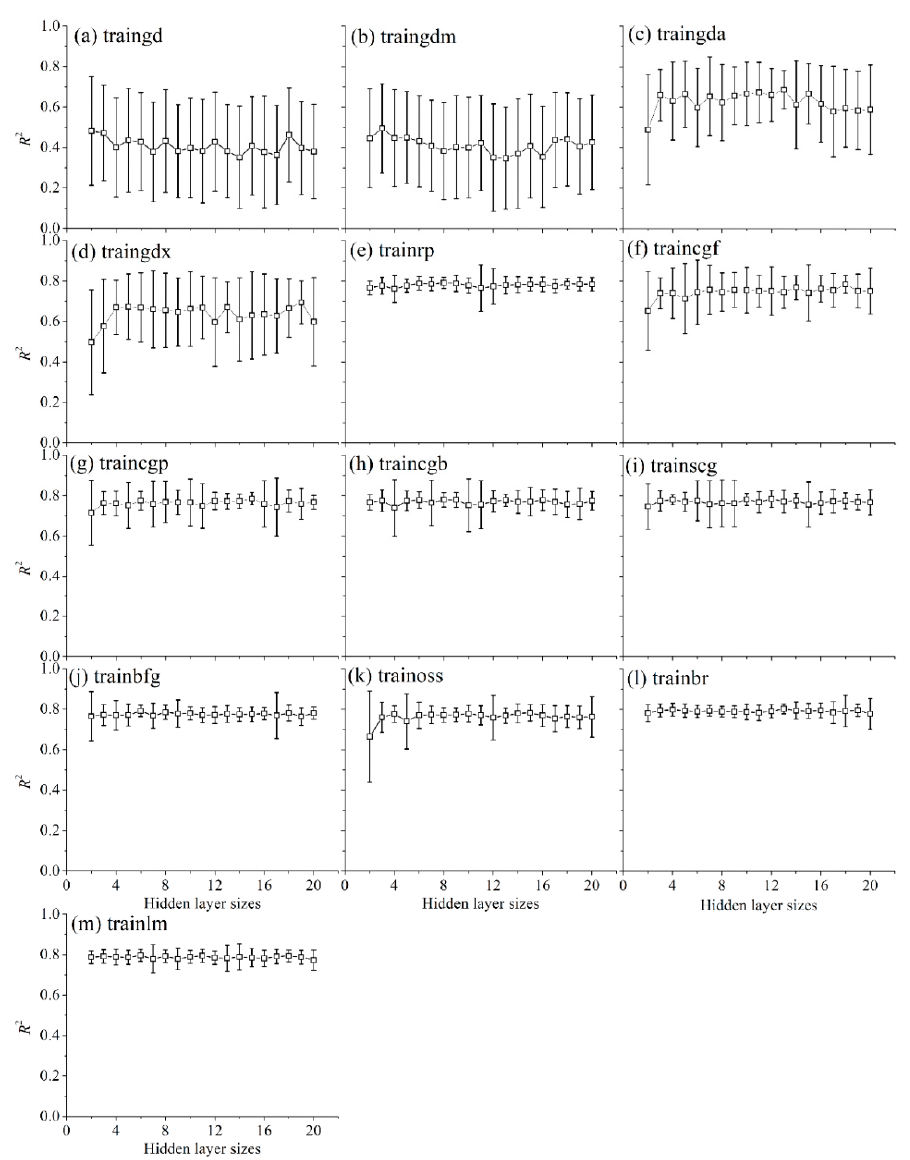
Figure 5. Performance of the proposed fluorescence indices for LNC estimation based on BPNN model with hidden layer sizes for different training function. The black error bar represents one standard deviation of mean values.